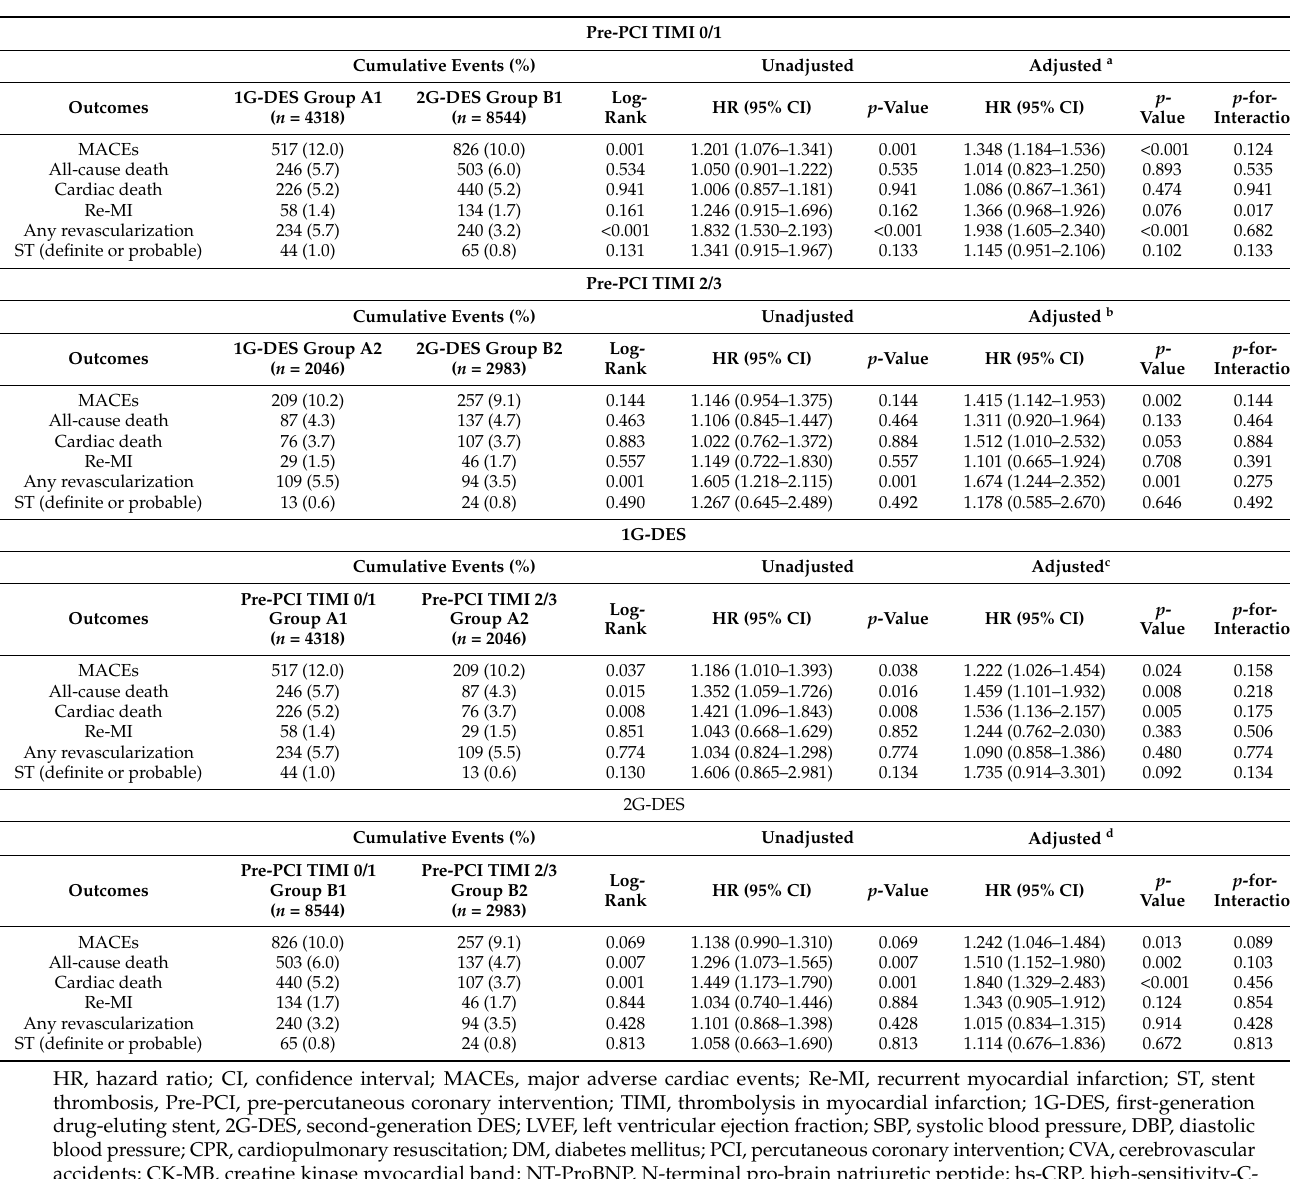
Table 2. Clinical outcomes by Kaplan–Meier analysis and Cox-proportional hazard ratio analysis at 2